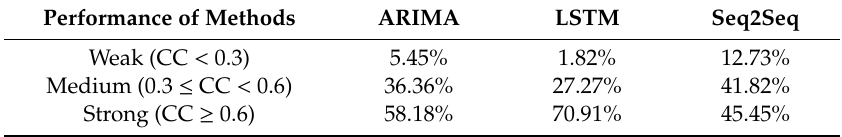
Table 3. Statistical distribution of the correlation coe ffi cients for three predictive